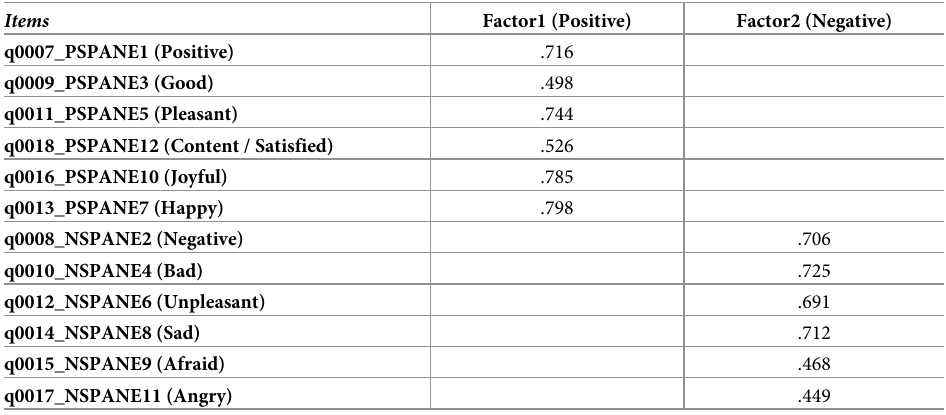
Table 5. Confirmatory factor analysis—Factor